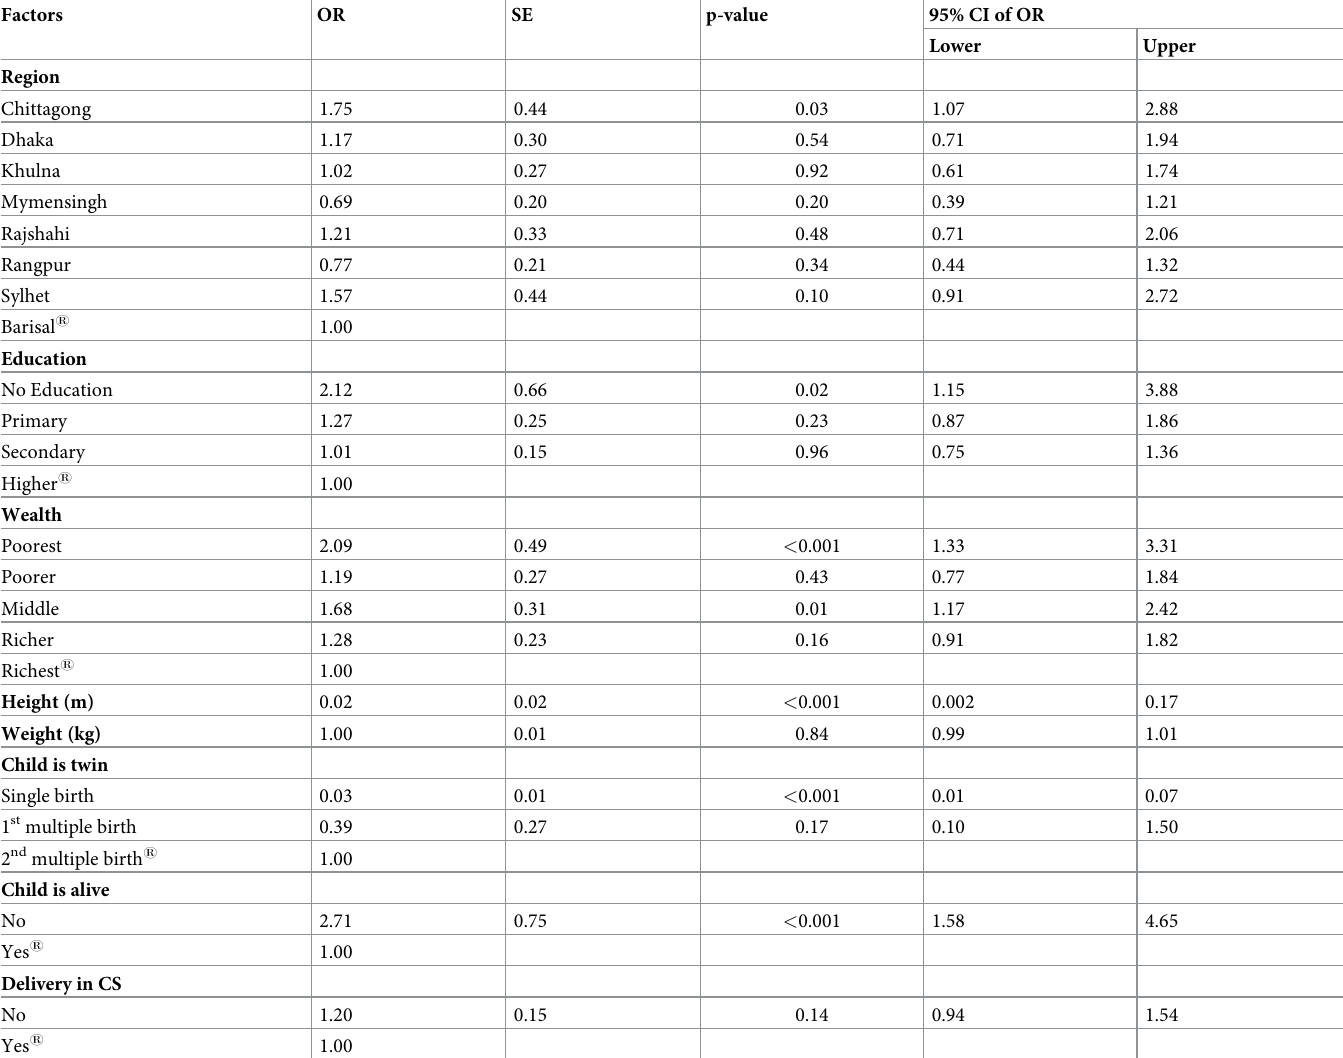
Table 3. Identifying the risk factors of LBW using the LR.